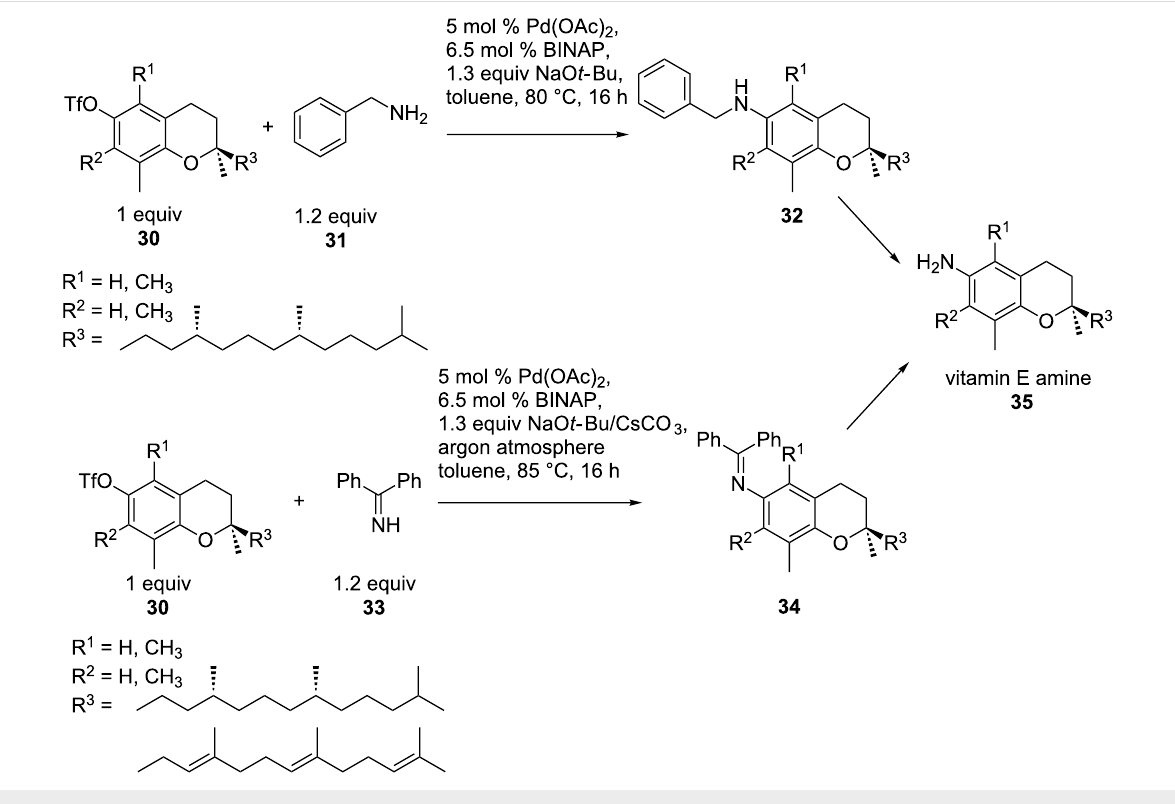
Scheme 8: Synthesis of vitamin E